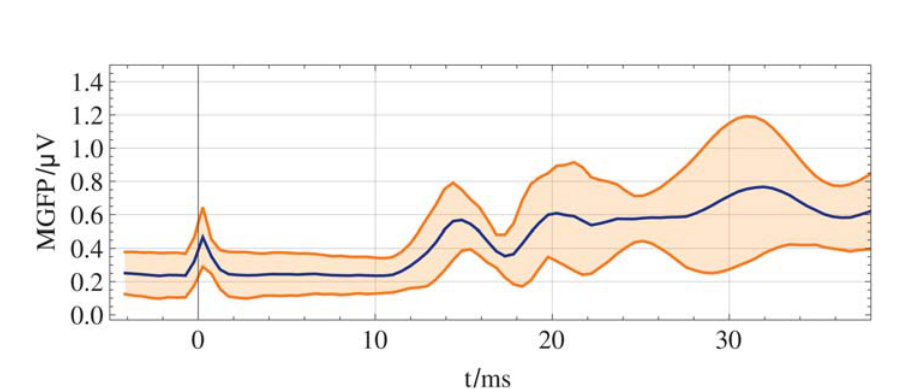
Fig 4. Grand average of SEP data. The grand average of the MGFP is marked by the blue line. The range of the grand average ± the standard deviation at the time sample is orange shaded.